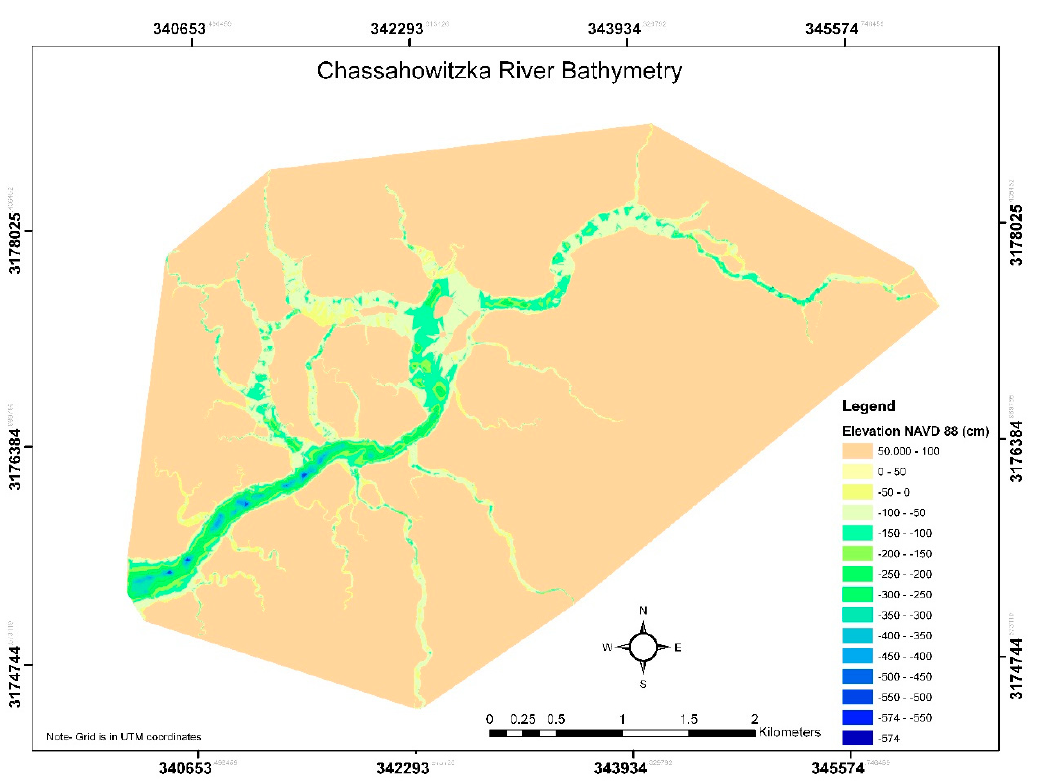
Figure 2. Bathymetry surveyed by Wang [16] in the Chassahowitzka River system.